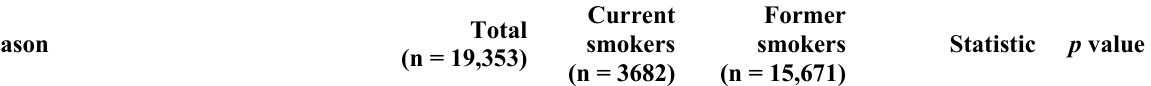
Table 3. Reasons for electronic cigarette use initiation and concepts about their risk